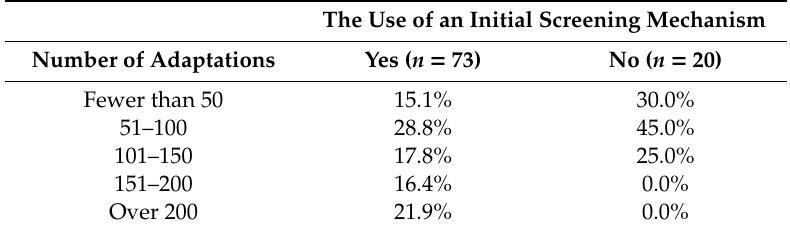
Table 3. Crosstabs between the screening mechanism and delivery